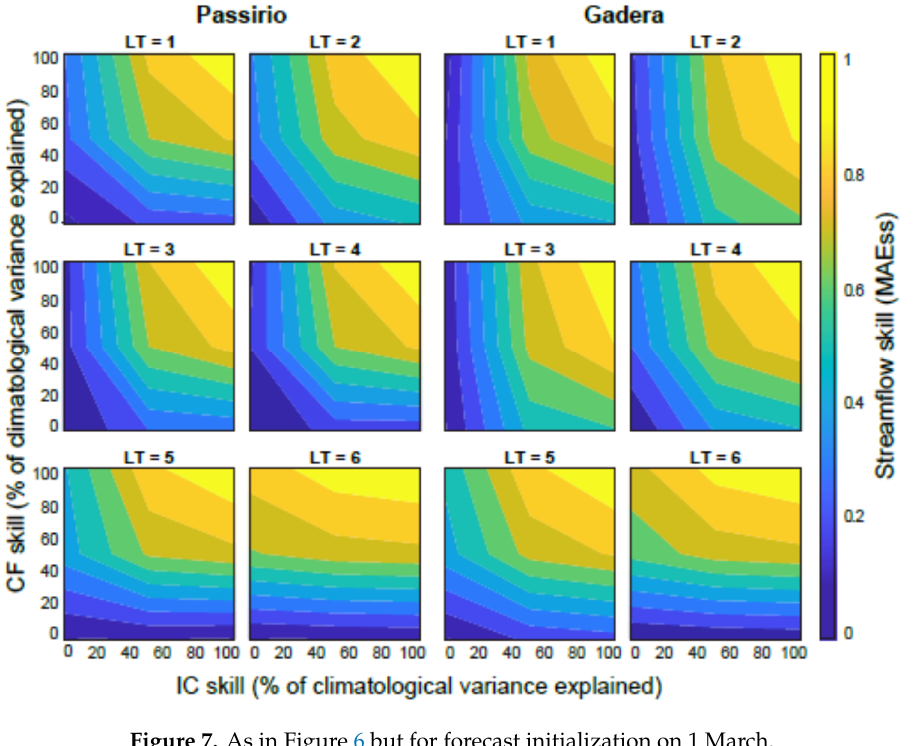
two predictability sources (IC, CF). The results are presented for a LT of 1 to 6 months.